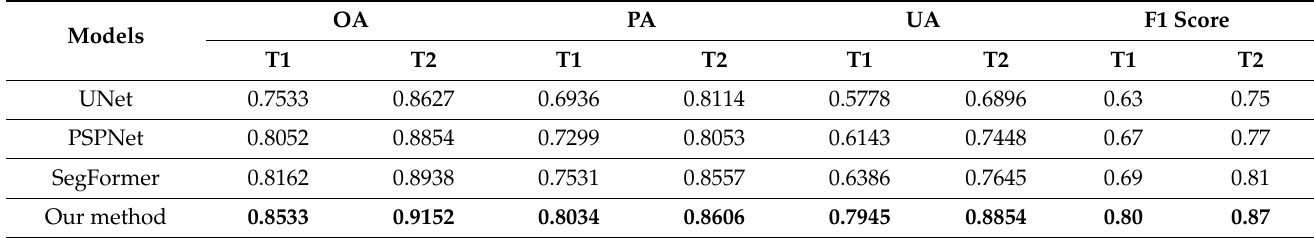
Figure 9. The BA results in T2: ( a ) Google Earth image, ( b ) ground truth, and ( c – f ) results based on UNet, PSPNet, SegFormer, and the proposed model. The orange oval marks the omissions. Table 5. Extraction accuracy in study areas 1 and 2 based on the four